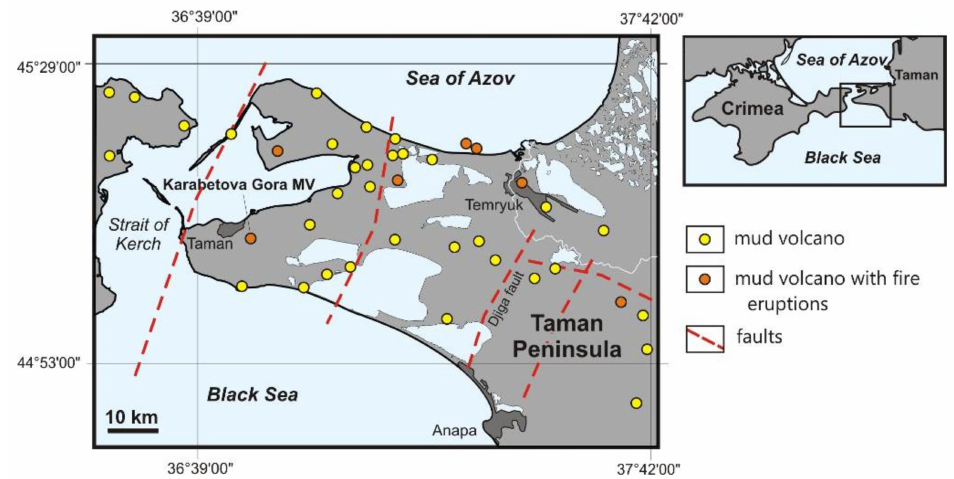
Figure 1. Location map of mud volcanoes in the Taman Peninsula (Kerch–Taman MV Province), modified after Shnyukov et al. [23].